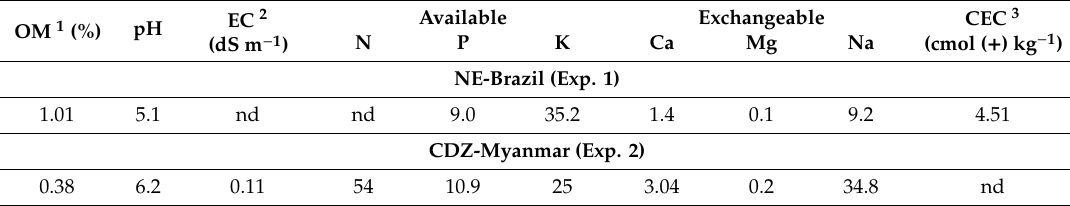
Table 3. Chemical characterization of the soils in the two